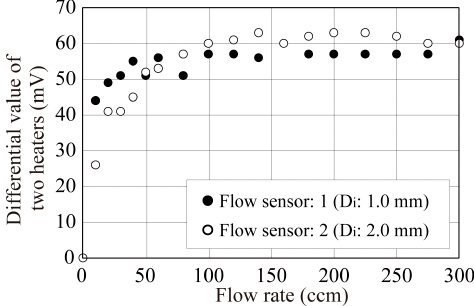
Figure 5. Differential values of two heaters vs.